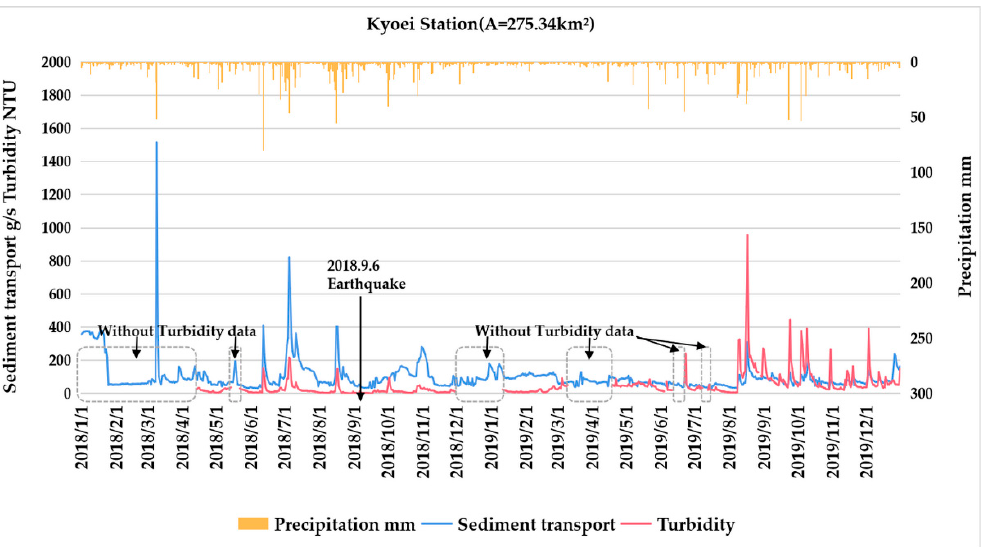
Figure 7. Comparison of turbidity and sediment transport at Kyoei station.